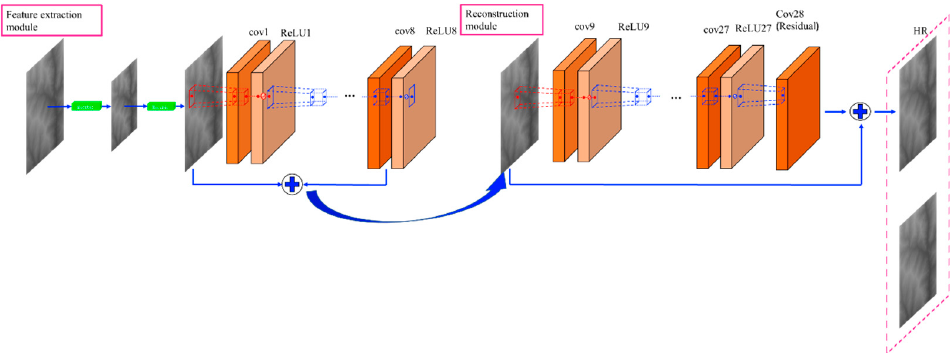
Figure 4. Network structure.